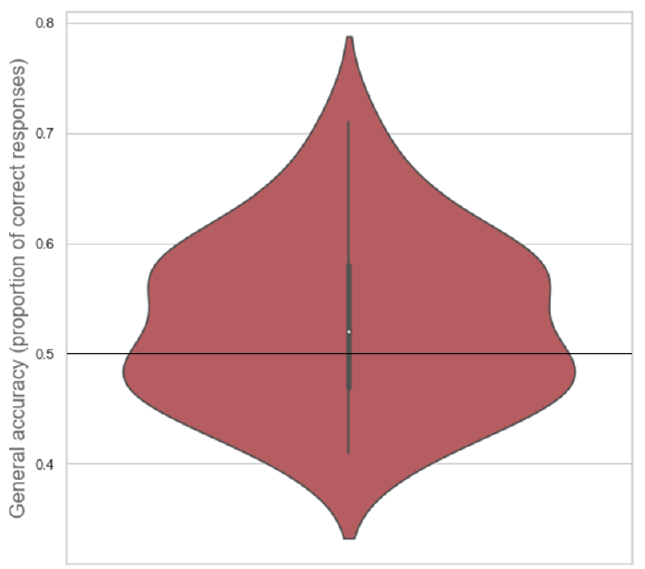
Figure 3. Violin plot of the distribution of general accuracy scores with median (white dot), 1.5 × interquartile range (grey vertical line), and chance level (black horizontal line) indicated. Larger surface area indicates more scores at that